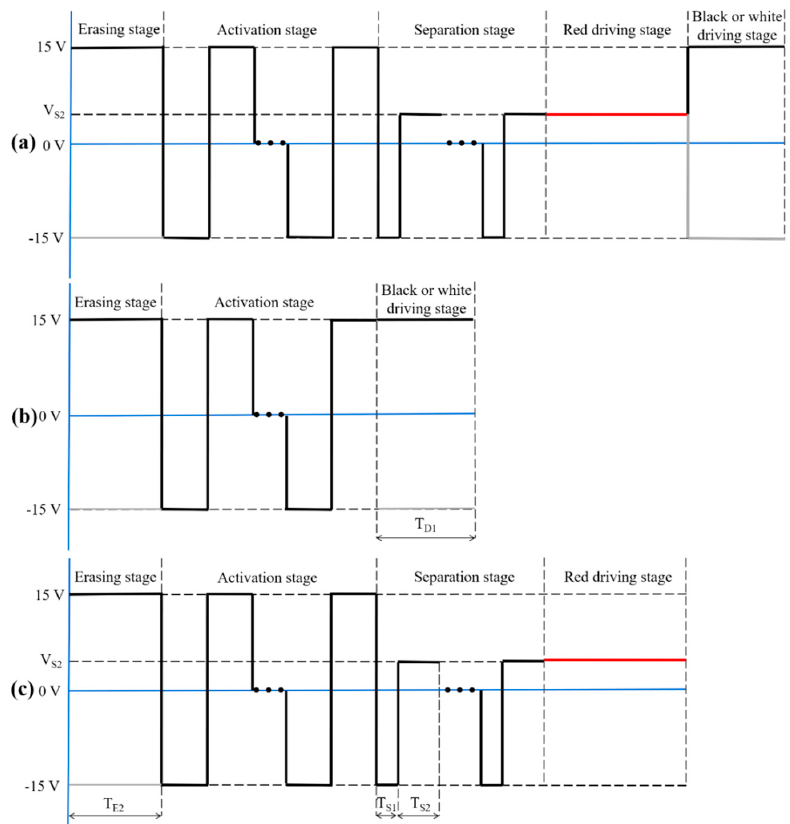
Figure 2. Driving scheme for increasing red saturation. ( a ) A complete structure of a driving scheme. It was composed of an erasing stage, an activation stage, a separation stage, a red driving stage, and a black or white driving stage. ( b ) An example of driving schemes which could be used to display a black image. ( c ) An example of driving schemes which could be used to display a red image.